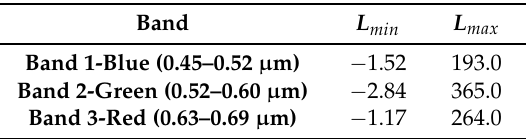
Table 3. Constant value for rescaling gains and biases for Landsat 5 TM. Source: